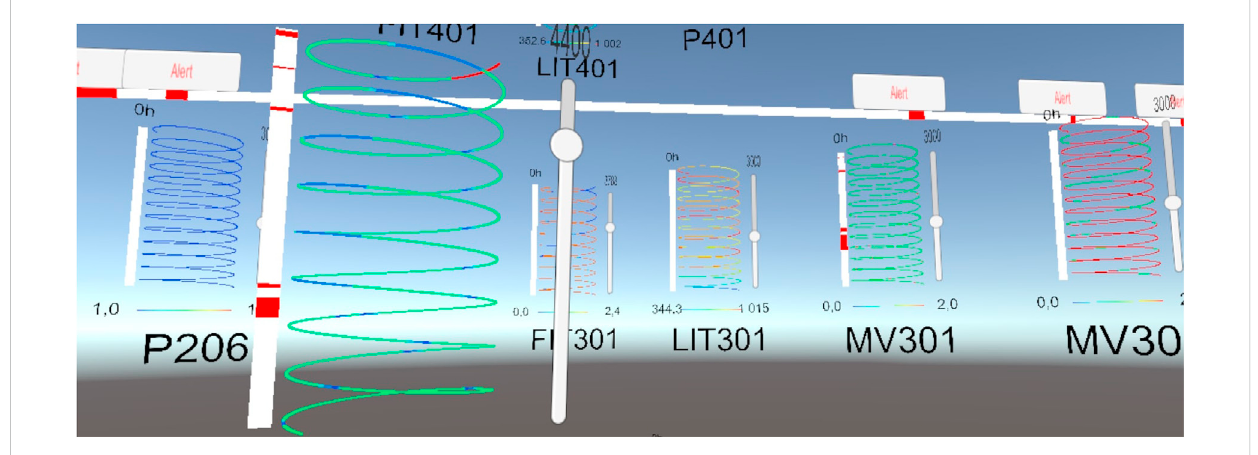
FIGURE 2 GlobalviewoftheCybercoptersswarm:Eachhelixrepresentsthevalueofonesensorduring10 h.Alargealertbarcanbeaddedintheenvironment to give a general idea of when alerts occur.